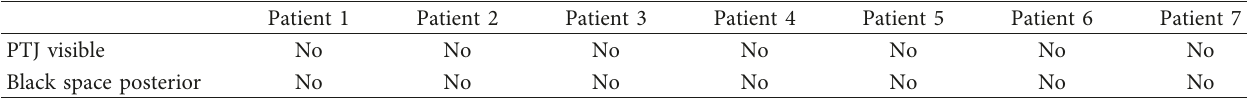
Figure 5: Pre- and post-OPG. In the postop OPG, we can see the guided ostectomy of the maxilla and the implants positioning. Table 3: Aesthetic parameter